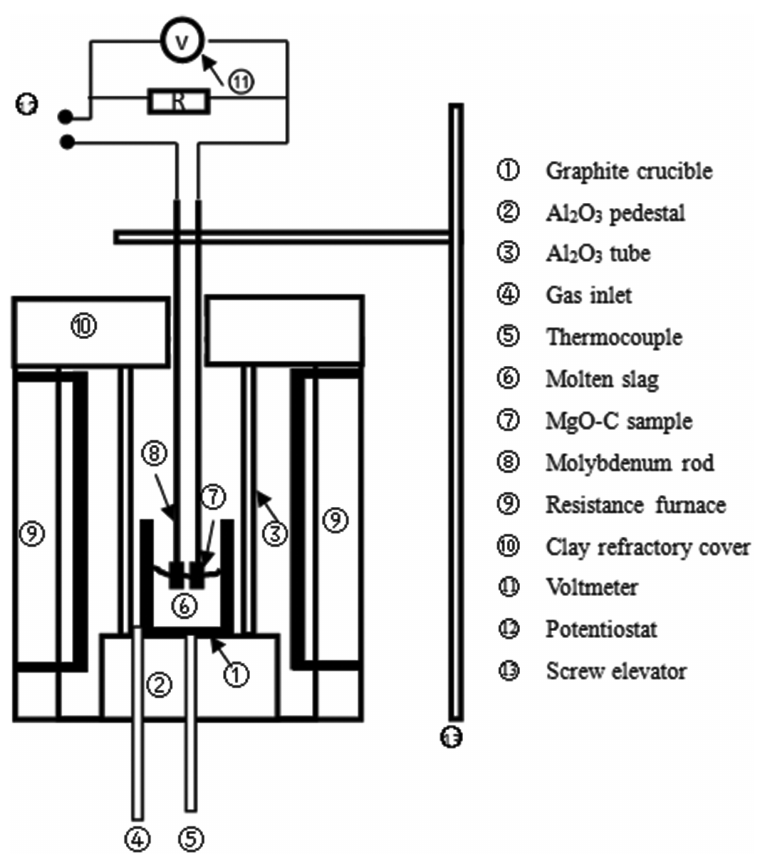
Figure 1: Scheme of the test furnace